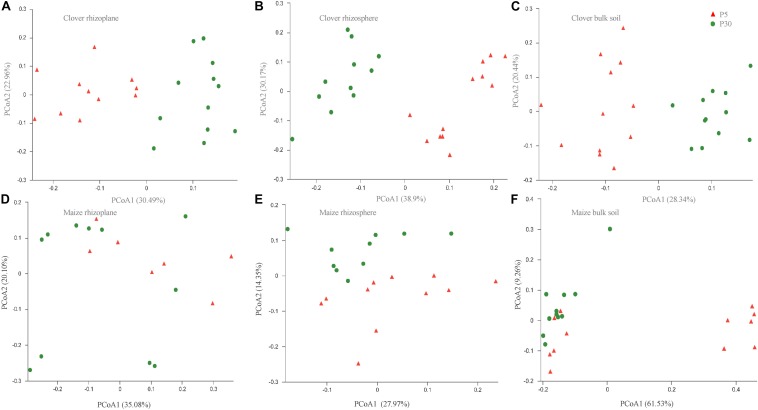
Bacterial communities in different rhizocompartments (rhizoplane, rhizosphere, and bulk) of clover and maize plants in response to substrate P levels. (A) Clover rhizoplane; (B) clover rhizosphere; (C) clover bulk; (D) maize rhizoplane; (E) maize rhizosphere; and (F) maize bulk. Principal coordinate analysis (PCoAs) plots of the OTU-based Bray–Curtis distance between all samples. The variance explained by each PC axis is given in parentheses. P5 and P30 represented the substrate P fertilizers with 5 and 30 mg P kg– 1 soil.